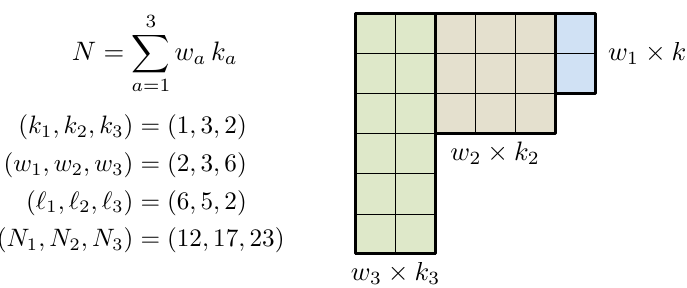
Figure 3 . An example of a (cid:13)ux con(cid:12)guration for N = 23 and associated Young diagram. The con(cid:12)guration has p = 3 monopole sources with prescribed k a , w a . We highlighted the decomposition of the Young diagram in rectangular blocks of dimensions w a